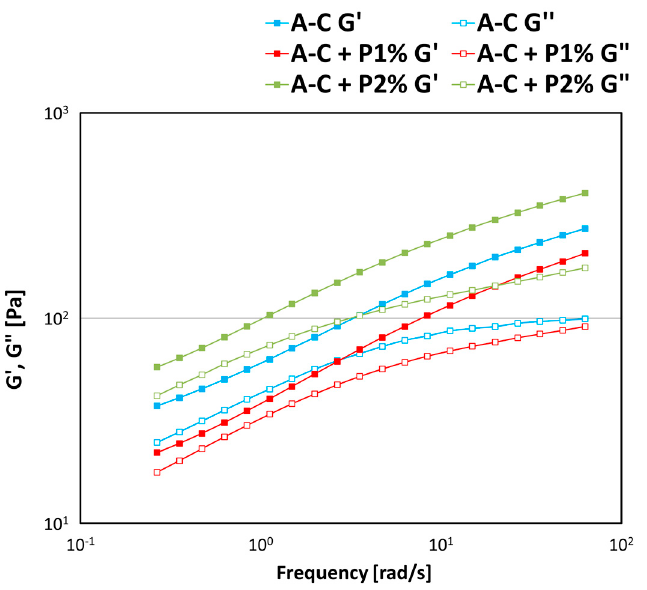
Figure 11. Storage (G ′ ) and loss (G ″ ) moduli trends as a function of the frequency for the samples